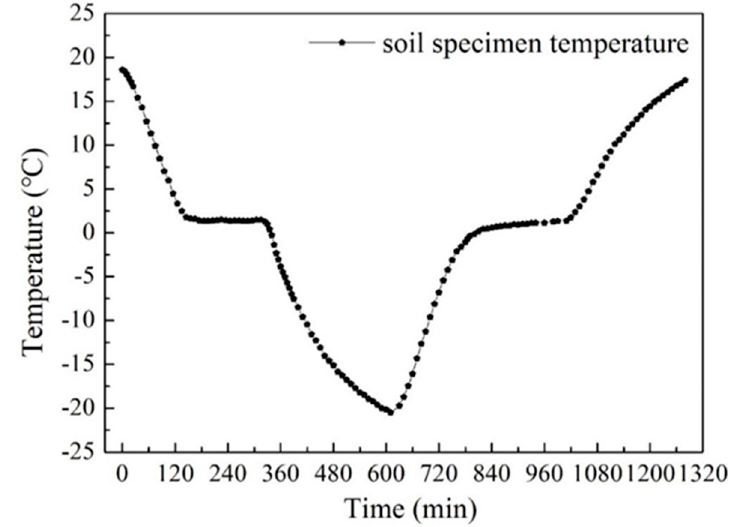
Figure 4. Soil temperature with variation of time.